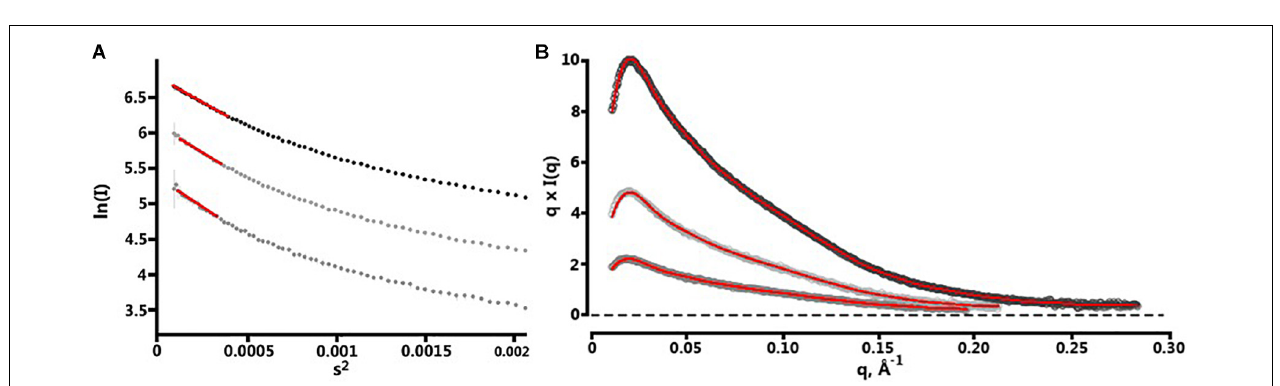
FIGURE 4 | Fitting of SAXS data. (A) Plotted data of the Guinier regions (points 1–74) for each concentration of BT2857. 10 mg/ml at top, 5 mg/ml middle, and 2 mg/ml bottom. The linear region is illustrated by red trendlines overlaid on each set of points. 10 mg/ml sample showed linearity from points 4 to 21, 5 mg/ml from 4 to 20, and 2 mg/ml from 4 to 18. (B) Depicts the P(r) curves fitted using SPI; concentrations are arranged in the same manner as panel (A)